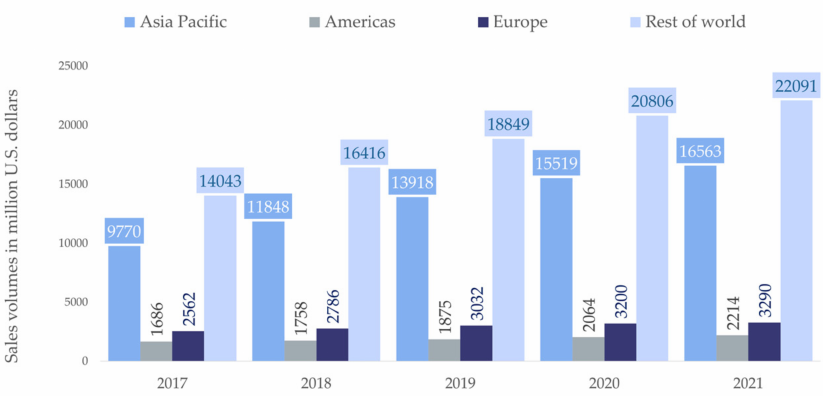
Figure 2. Sales volume of industrial robots by continent. Source: Author’s contribution, based on Statista, https://www.statista.com/study/64326/robotics/, accessed on 19 March